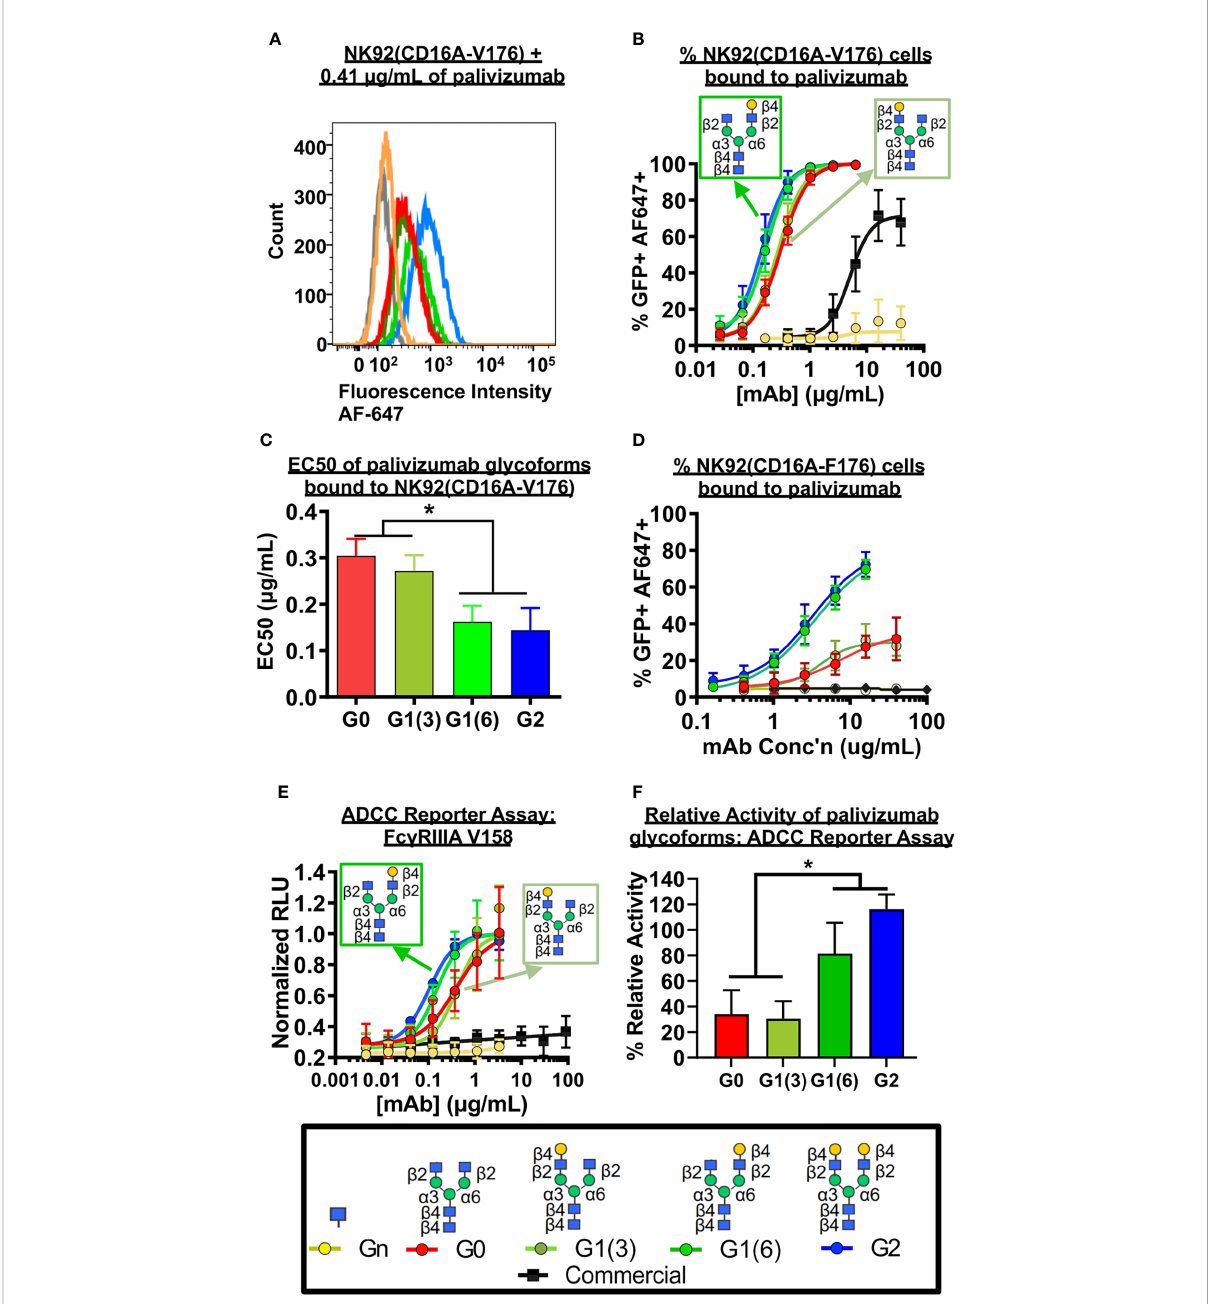
FIGURE 4 Fc g RIIIa (CD16A) binding shows galactose on the a 6 antenna signi fi cantly affects activity - Cell based assays. (A-C) NK92-CD16A expressing cells (V Variant) and (D) Jurkat T-cell luciferase reporter cell line (CD16A V Variant). (A) A representative fl ow cytometry histogram is shown of NK92- CD16A (V176) cells bound to 0.41 µg/mL of various palivizumab glycoforms that were detected using an anti-human IgG (F(ab ’ ) 2 – speci fi c) conjugated to AlexaFluor(AF)-647. (B) Dose-response curve of % GFP+APC+ cells for each palivizumab glycoform analogue (C) EC 50 (µg/mL) shows that galactosylation in the a 6 antenna result in approximately twice as low EC50 compared to glycoforms lacking galactosylation in this position. EC50s are calculated using GraphPad. *, p< 0.05, One-way ANOVA, Tukey post-hoc analysis. (D) Dose-response curve of % GFP+APC + cells for each palivizumab glycoform analogue to NK92-GFP cells expressing the low-af fi nity CD16A F176 variant. (E) Dose-response curve and (F) % relative activity of palivizumab glycoforms in the ADCC reporter assay, where % relative activity is the ratio of the EC50 of G2- palivizumab to the EC50 of each sample in each biological replicate. For (B-F) , error bars show mean ± standard deviation (n=3 biological replicates); for (B, D, E) non-linear regression (4-PL) was used for curve- fi tting in GraphPad; for (C, F) EC50 values were calculated and statistical analyses were performed using GraphPad. *, p< 0.05, One-way ANOVA, Tukey post-hoc